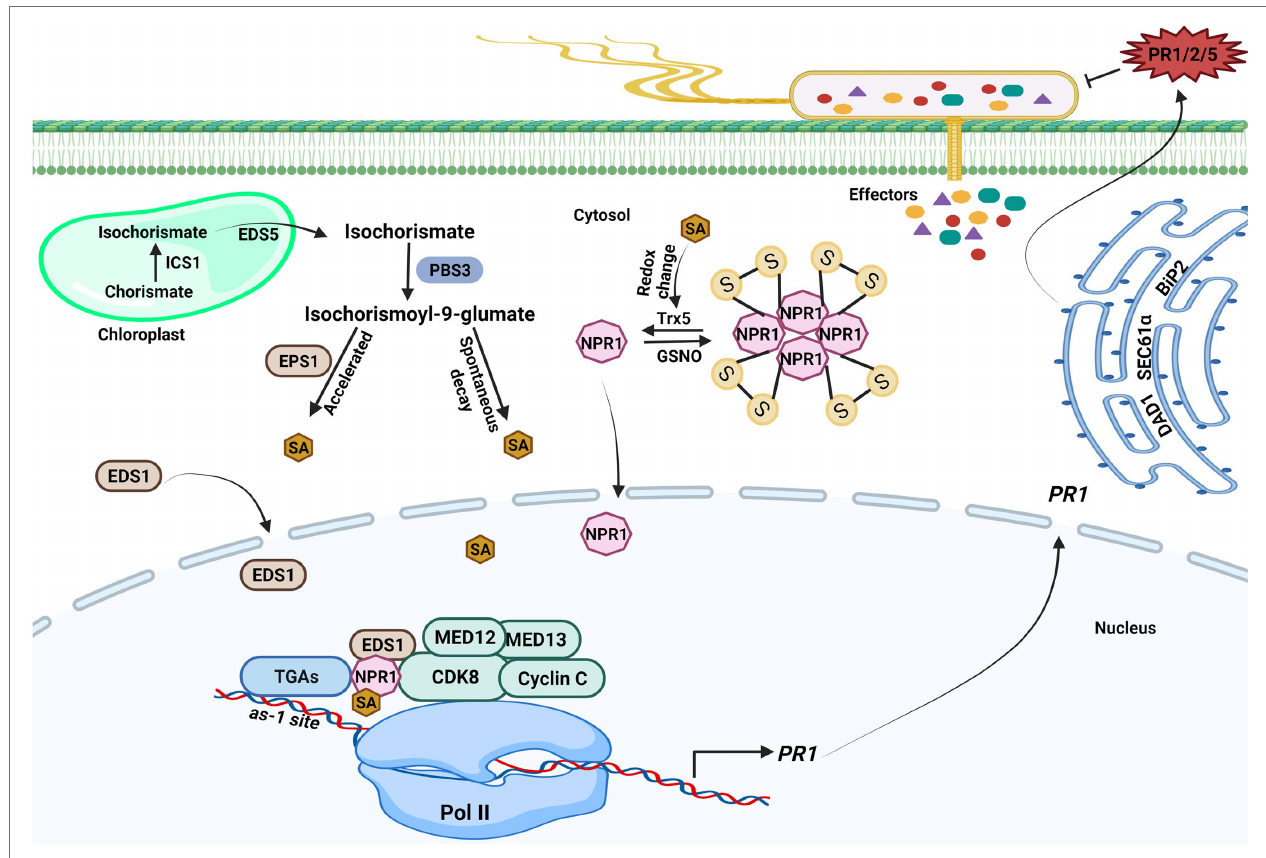
FIGURE 1 | Transcriptional regulations of salicylic acid-mediated plant immunity. Upon pathogen infection, salicylic acid (SA) generation is initiated in the chloroplast. ICS1 catalyzes the conversion of chorismate to isochorismate, and then, isochorismate is exported to the cytosol by Enhanced Disease Susceptibility (EDS5) 5. PBS3 catalyzes the conjugation of L-glutamate to isochorismate in the cytosol, resulting in isochorismate-9-glutamate. SA is produced from isochorismate-9-glutamate through spontaneous decay. The EPS1 acts as an isochorismate-9-glutamate pyruvoyl-glutamate lyase that could also break down N-pyruvoyl-L-glutamate to create SA. The NPR1 gene expression is aided by SA because it encourages the interaction between the WRKY transcription factors and NPR1, which brings cyclin-dependent kinase 8 (CDK8) to the NPR1 promoter’s W-box and enables gene expression. The CDK8 kinase module mediators are also implicated in PR1 gene expression. SA also promotes redox changes, which reduces NPR1 oligomers to monomers. The monomeric NPR1 molecule travels from the cytosol to the nucleus and activates downstream NPR1-dependent genes. NPR1 physically interacts with other coactivators, such as Enhanced Disease Susceptibility (EDS1) 1 and CDK8, to positively regulate the expression of PR genes expression in an SA-dependent environment. The PR1 mRNA is further exported from the nucleus to the cytosol to produce PR1 protein. ER-resident genes ( SEC61 α , DAD1 , and BiP2 ) govern the secretion of PR proteins into the apoplast to counter pathogen. The figure was created with